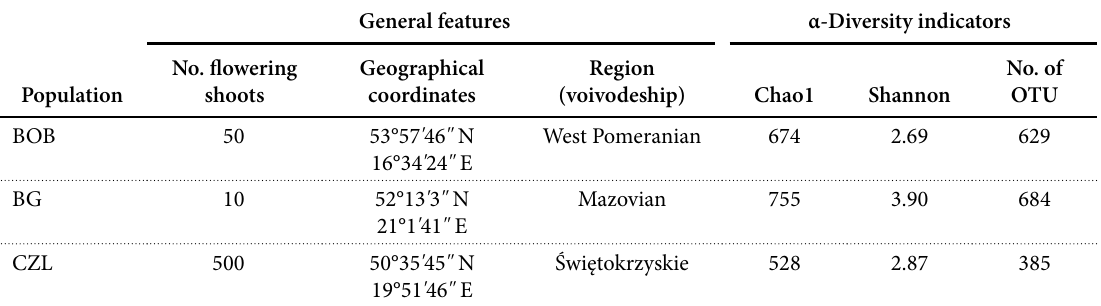
Tab. 1 The features of investigated P. caeruleum